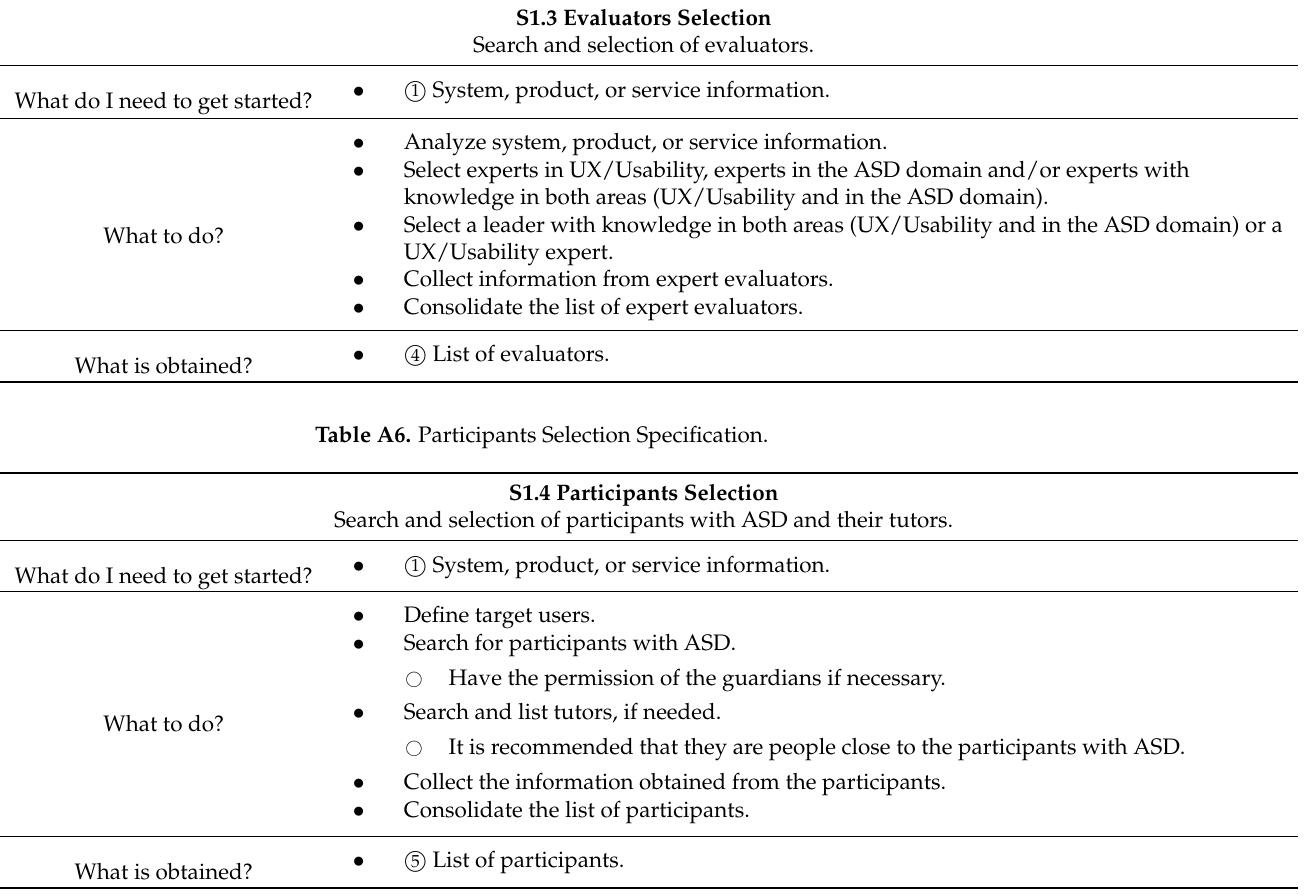
Table A5. Evaluators Selection Specification.